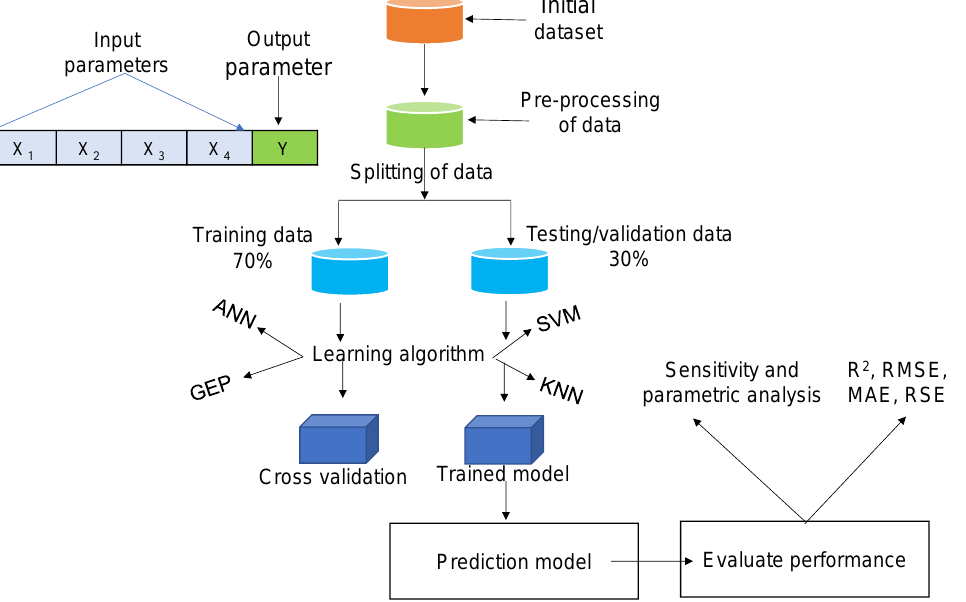
Figure 1. Steps involved in developing prediction model using artificial intelligence techniques.